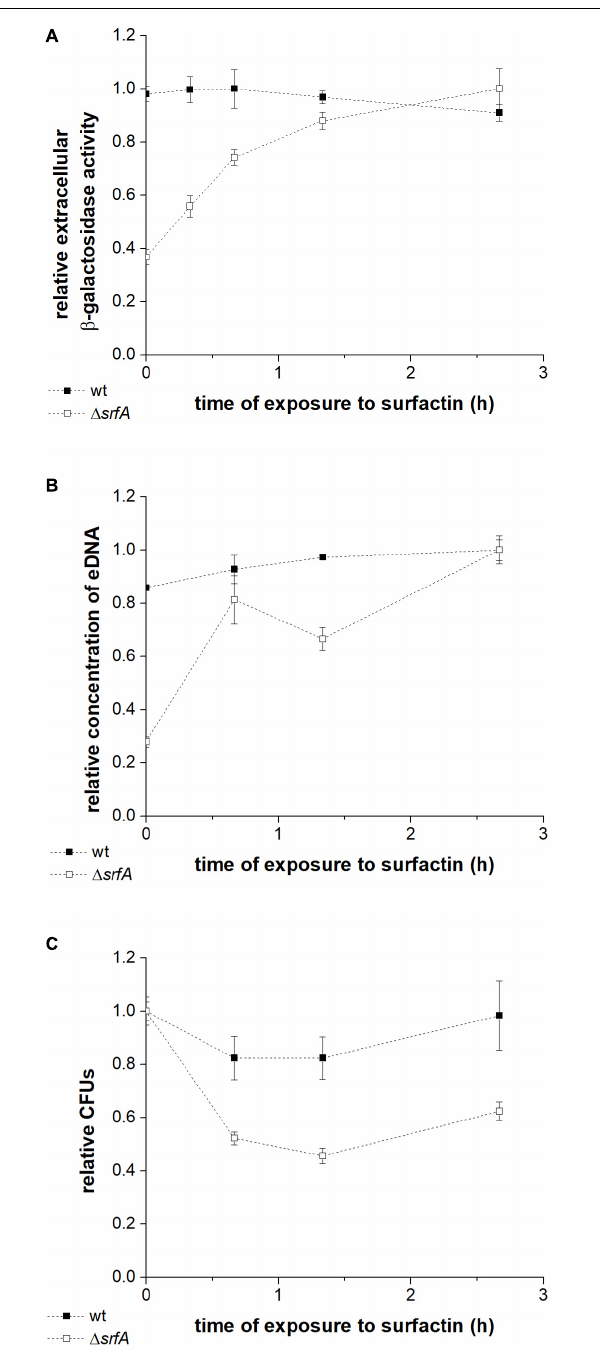
FIGURE 3 | Extracellular β -galactosidase activity in the conditioned medium (A) , DNA released into the medium (B) , and colony-forming units (C) in the wt lacZ (BM1298) (black squares) and (cid:49) srfA lacZ (BM1299) (white squares) strains after different lengths of exposure to surfactin. Both strains were grown until early stationary phase in CM medium at 37 ◦ C and 200 rpm and were then incubated with surfactin (20 µ g ml − 1 ) for 3 h at room temperature without shaking. Data were normalized with respect to the highest β -galactosidase activity (A) , eDNA concentration (B) , or CFU number (C) of all samples measured for a particular strain, and are presented in relative units. Values are presented as means and standard errors ( n = 3).